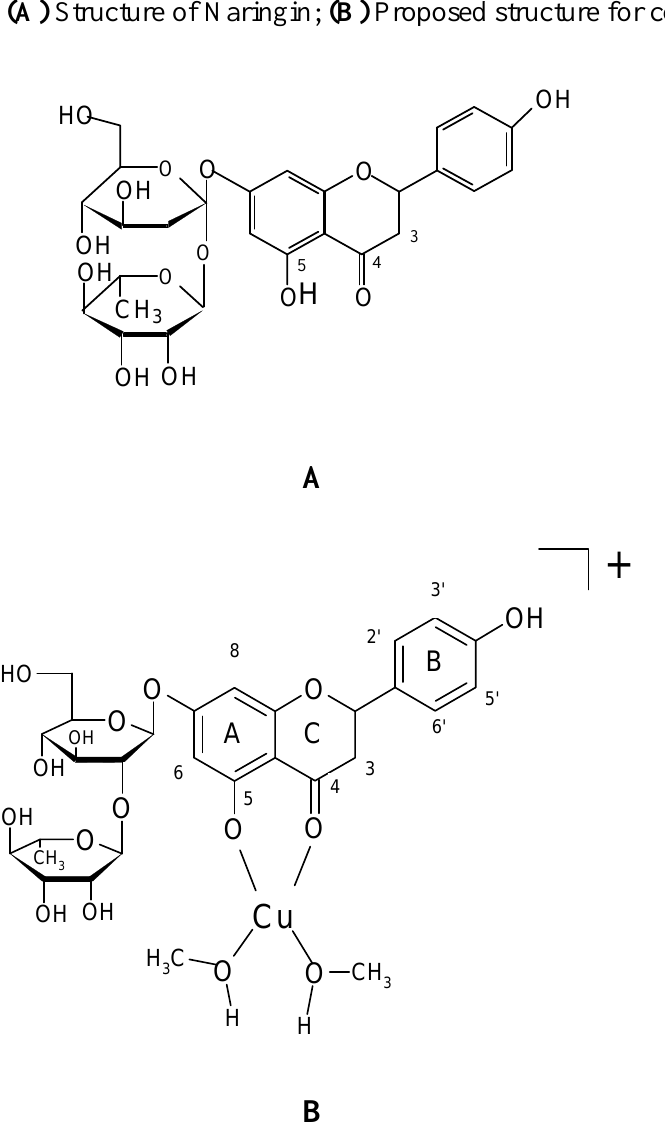
Figure 2. (A) Structure of Naringin; (B) Proposed structure for complex